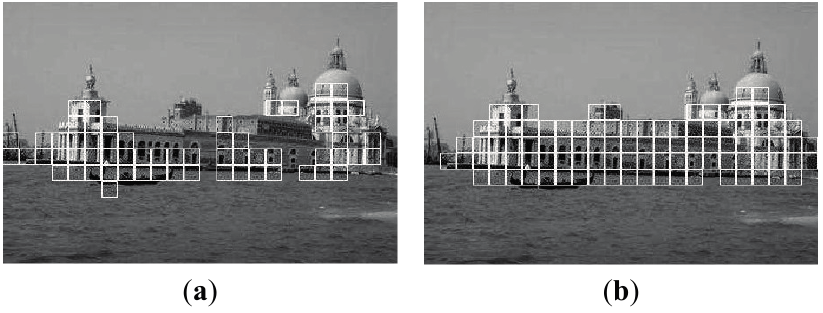
Figure 1. Example of man-made objects in a natural scene. Pixel patches (16 × 16 pixels) containing man-made structures are outlined. ( a ) MRF result; ( b ) CRF result.